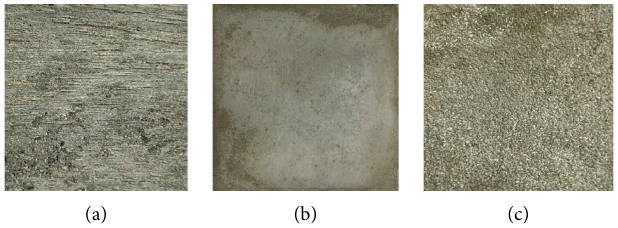
Figure 3: Visual inspection of three types of concrete surface manufactured by using (a) FN, (b) FC, and (c) FS